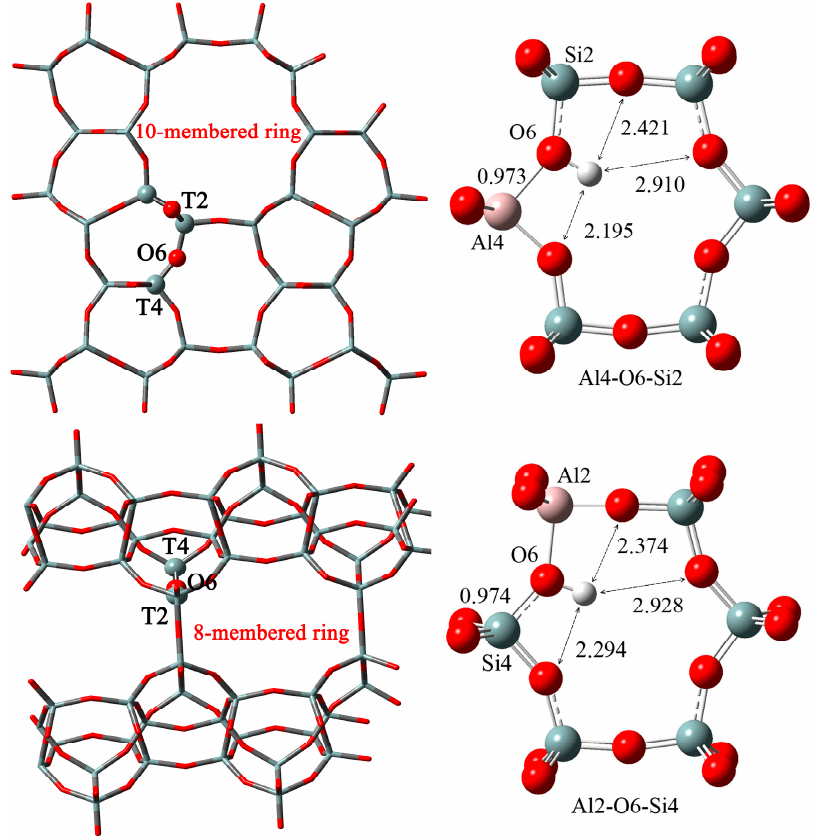
Figure 1. The location of T2 ‐ O6 ‐ T4 in framework and the structure parameters of hydrogen atoms in the hydroxyl group of Al4 ‐ O6 ‐ Si2 and Al2 ‐ O6 ‐ Si4 sites.